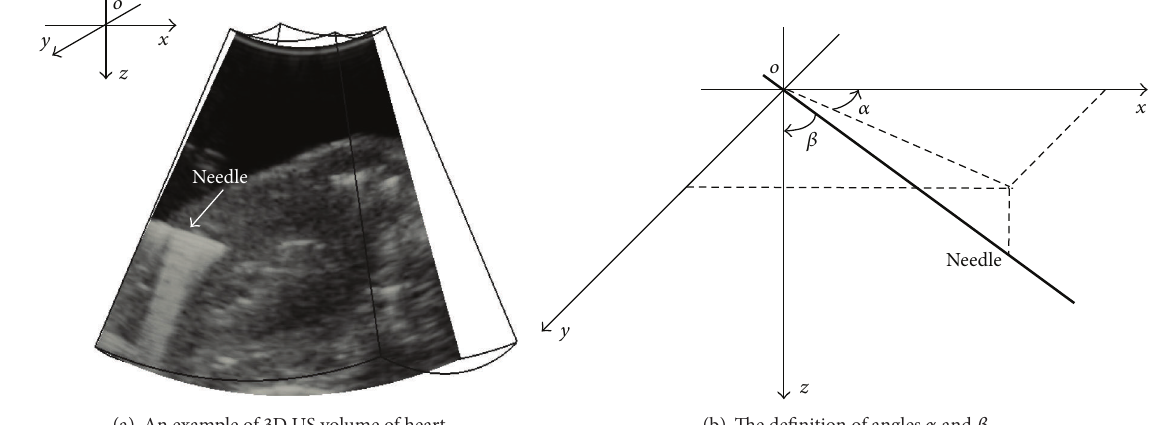
Figure 2: The sketch of the definitions of angles 𝛼 and 𝛽